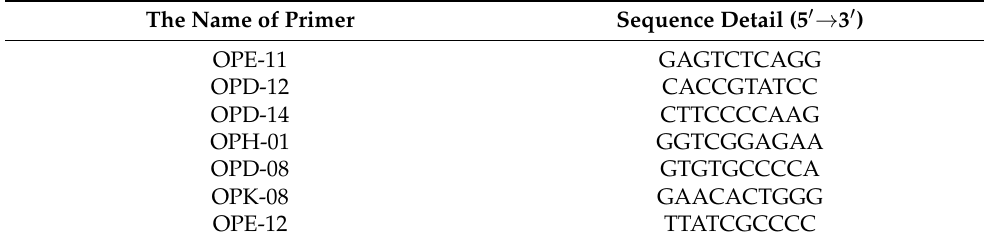
Table 8. The name of primers and their nucleotide